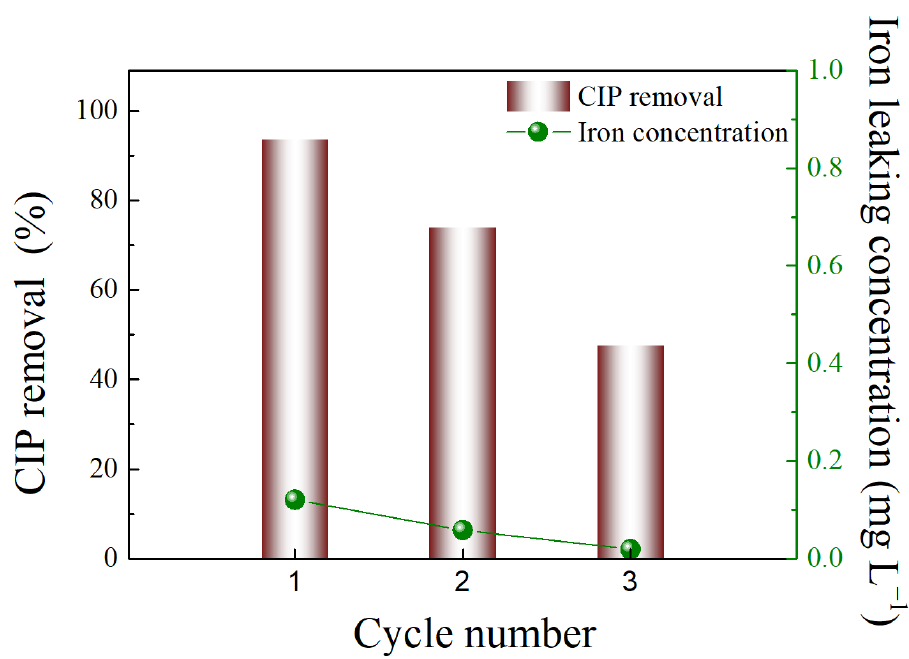
Figure 4. Durability and concentration of iron leaking of GQDs/α -FeOOH after 3-times reuse cycles.